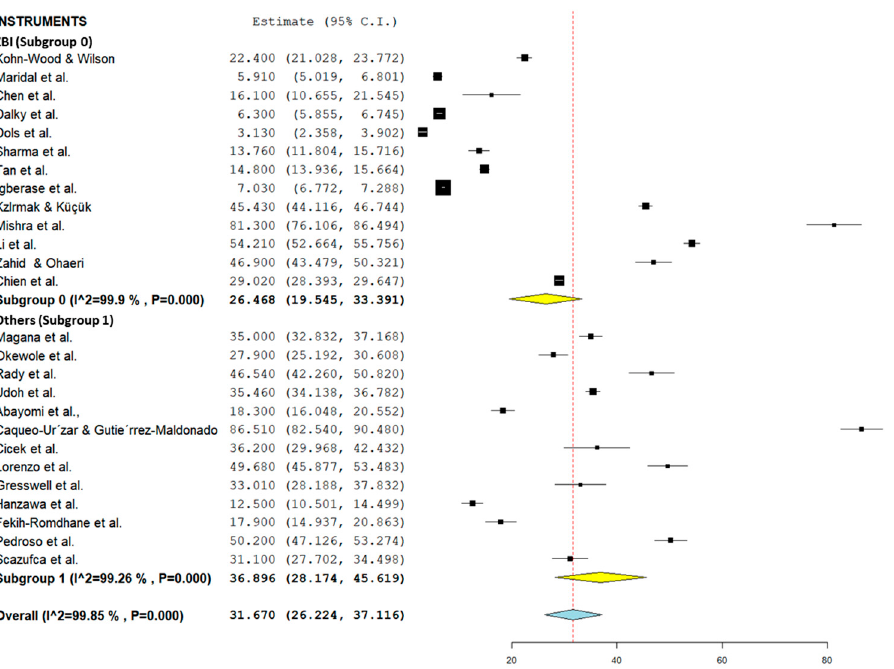
Figure 4. Subgroup forest plot on the types of measurement used (Zarit: [44,50–52,55,56,58,60,63,71,72,75,77]; Others: [6,18,40,41,48,49,54,62,64,65,68–70]).